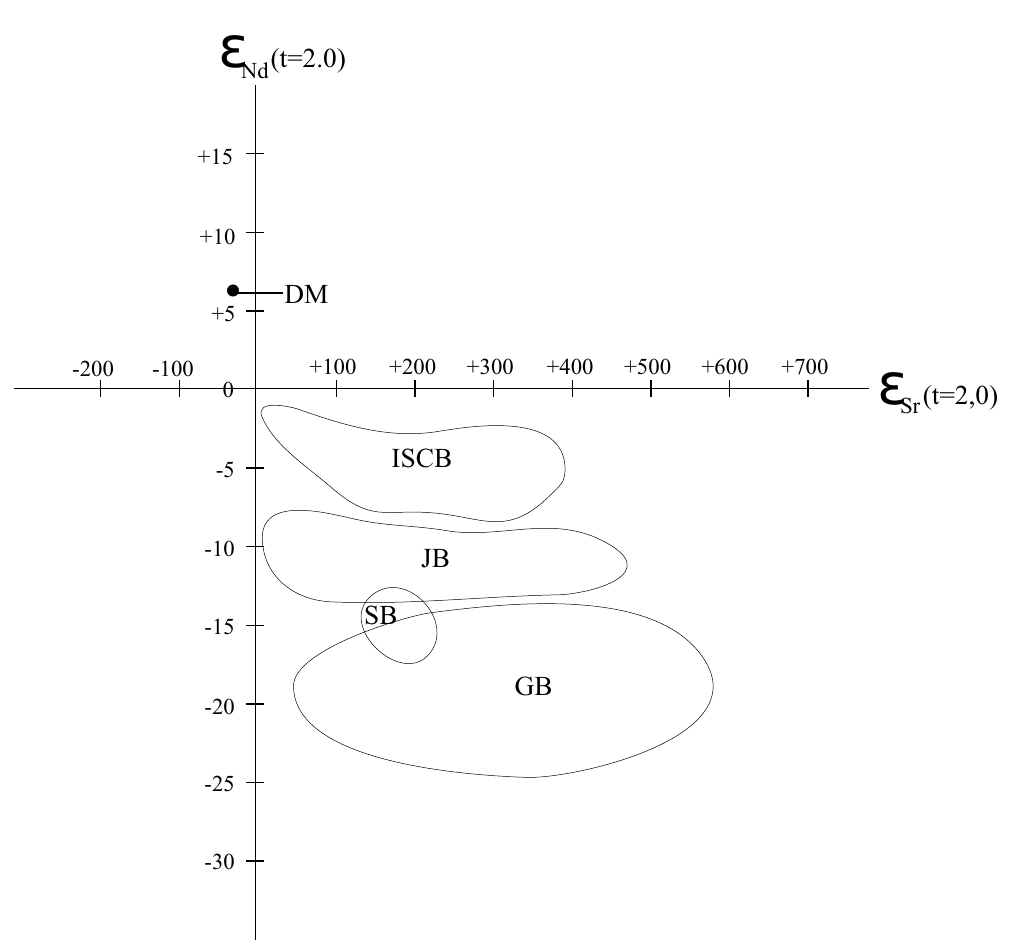
Fig. 3 – ε Nd × ε Sr (t = 2 . 0Ga ) diagram showing distinct isotopic fields, related to ISCB (Itabuna-Salvador-Curaçá Belt), JB (Jequié Block), SB (Serrinha Block) and GB (Gavião